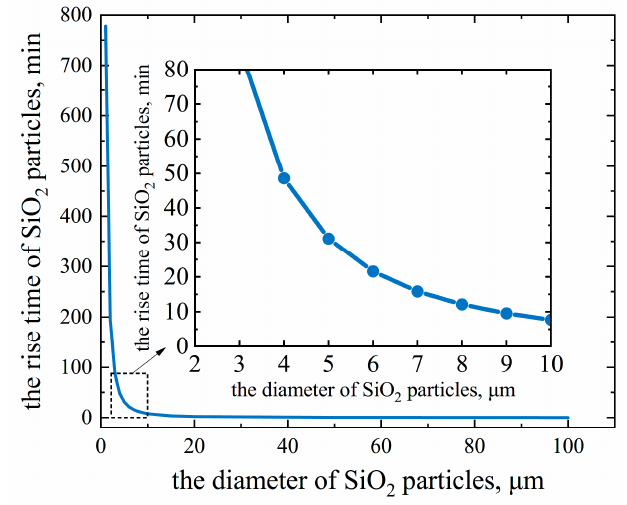
Figure 8. The time taken for SiO 2 particles of di ff erent sizes in molten iron to float up.